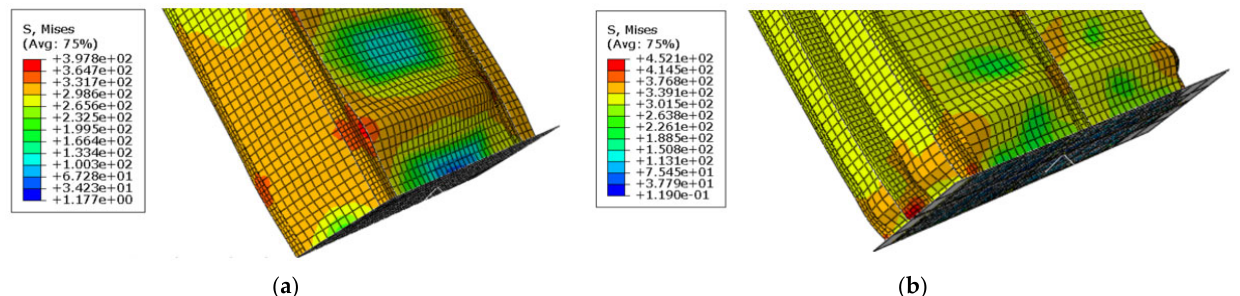
Figure 14. Buckling shapes by the FEM model. ( a ) 2 ‐ cell specimens; ( b ) 4 ‐ cell specimens.